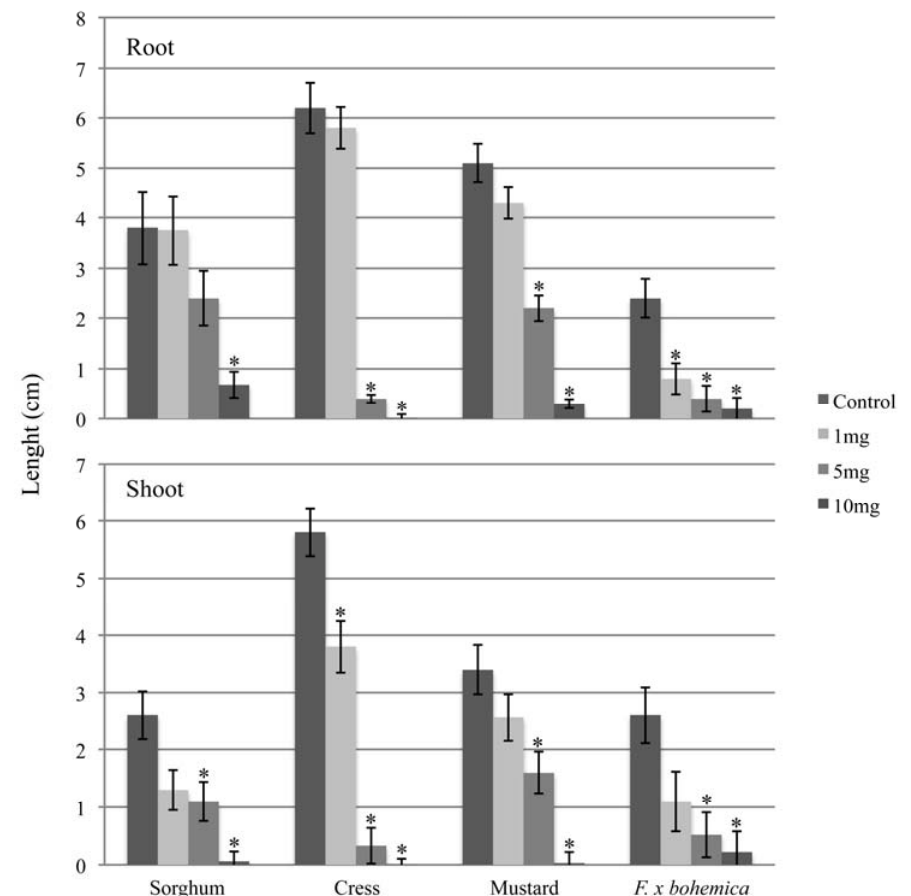
Figure 3. The effects of myrigalone A on the root and shoot growths of sorghum, cress, mustard and F. x bohemica . Concentrations are the total quantities of myrigalone A added to each Petri dish for the bioassays. Means ± SE are shown for three independent experiments with 5–10 plants per treatment. Significant differences with the control treatment ( P < 0.05, Tukey’s test) are indicated by